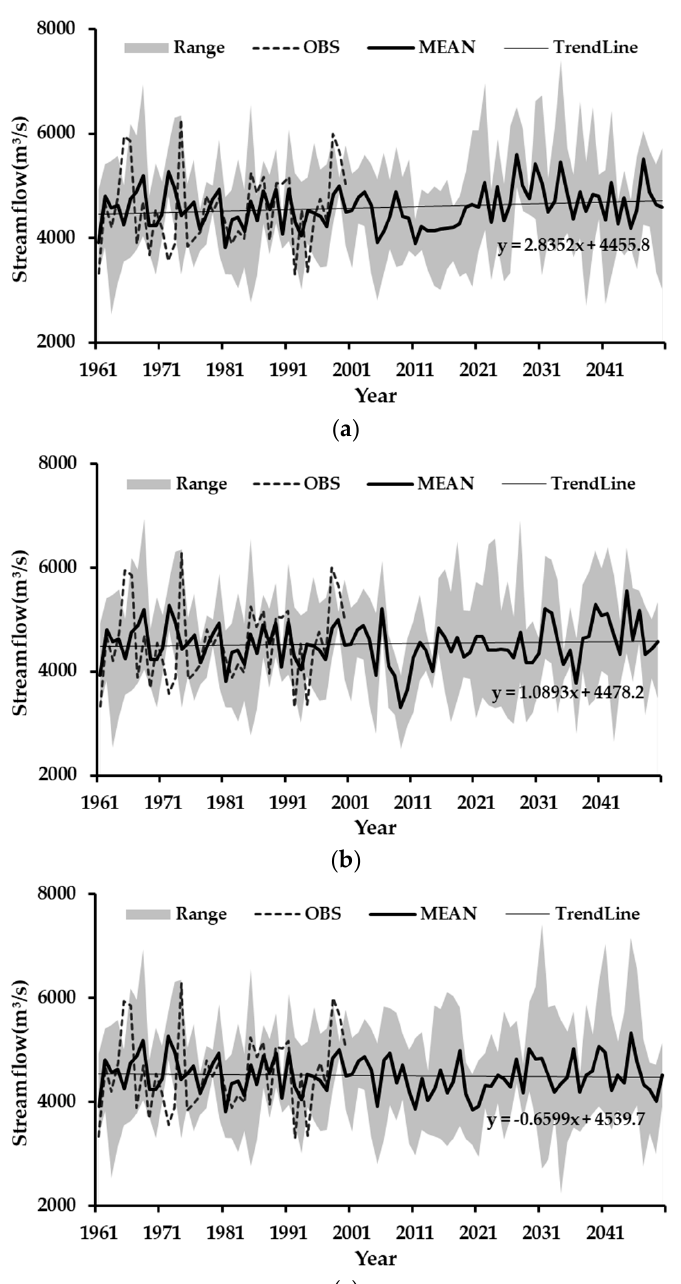
Figure 17. Annual streamflow in Pingshan Station under IPCC climate scenarios: ( a ) RCP2.6, ( b ) RCP4.5, and ( c )